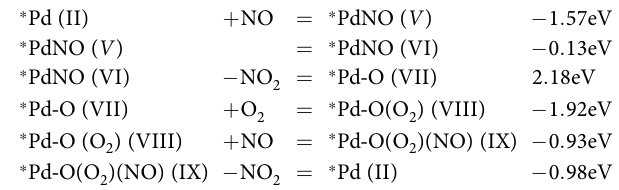
[Figure S4]. Finally, the release of NO 2 from configuration IX via an exothermic process regenerates configuration II. The energetics of reactions in Fig. 7 are summarized as follows: This mechanistic pathway suggests that there is a energy barrier to the release of first NO 2 ( − 2.18 eV) although rest of the steps are energetically favorable. This contrasts with CO oxidation pathway, described by Datye et al . 29 where CO 2 release is an exothermic process.